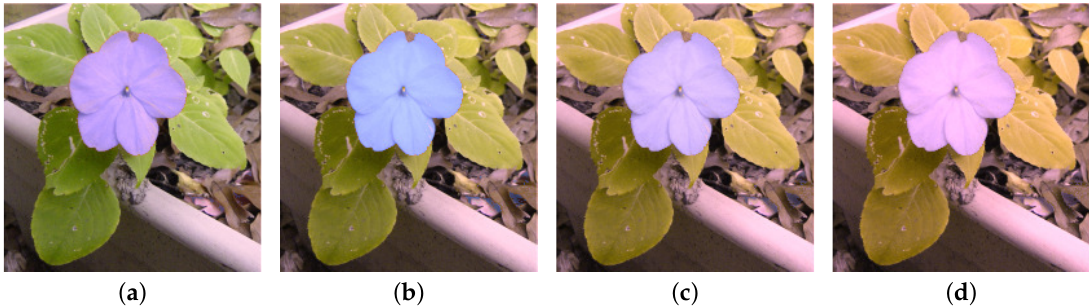
Figure 11. Enhancement sensitive of protanopia color vision deficiency, ( a ) with sensitivity 0.3, ( b ) with sensitivity 0.5, ( c ) with sensitivity 0.7, ( d ) with sensitivity 0.9.